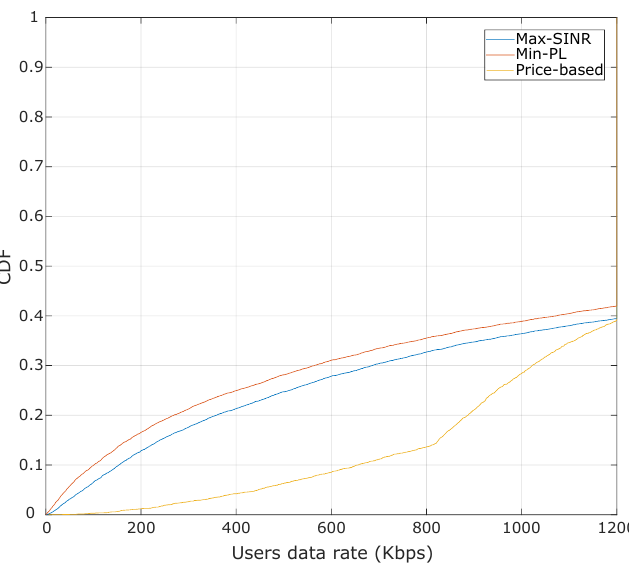
Figure 7. CDF of the data rate degradation for a R min c requirement of 600 Kbps for HTC devices and R min d